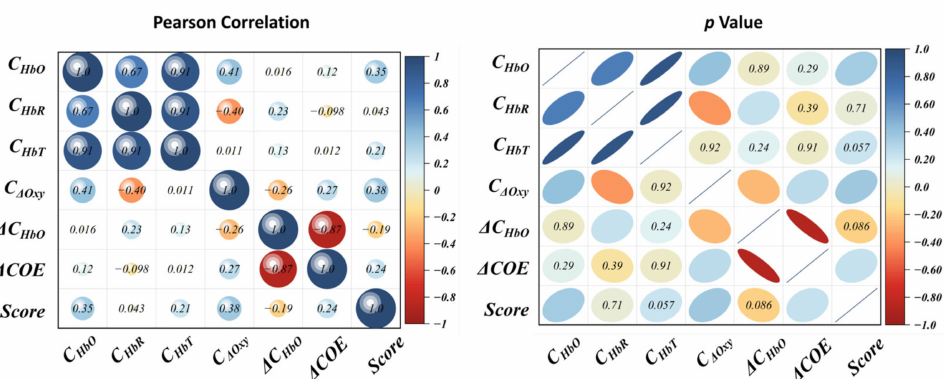
Figure 4. Pearson correlation analysis and significance test for independent and dependent